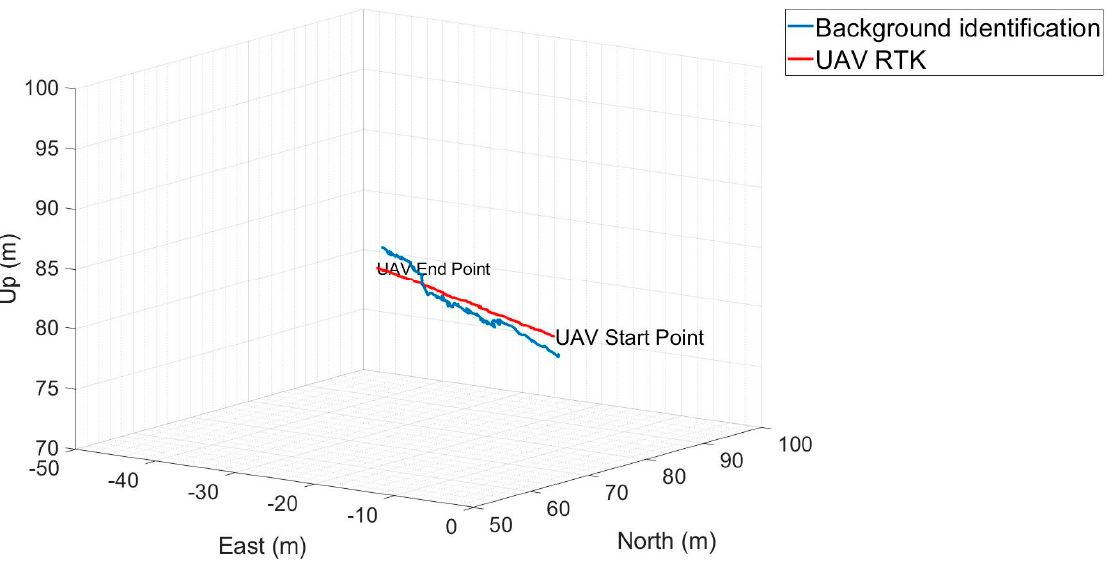
Figure 22. UAV RTK recorded the flight route, while background identification is to calculate the flight route.